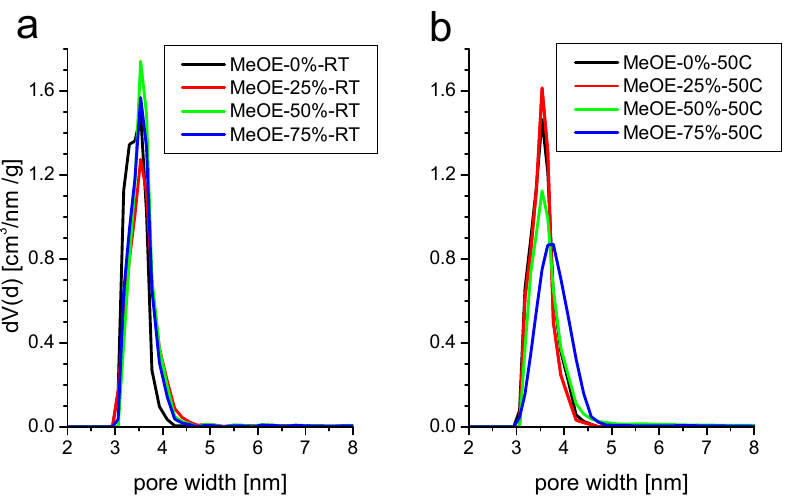
Figure 4. Pore size distribution of samples synthetized at room temperature ( a ) and at 50 ◦ C ( b ). The different texture of the materials was also observed in the surface fractal dimen- sions evaluated by Frenkel-Halsey-Hill (FHH) method [39]. The FHH model is used to Df 2 indicates smooth surface and 3 is characteristic for a porous surface [39]. The FHH data (Table 1) indicate that using methoxyethanol as co-solvent a smoother surface is obtained